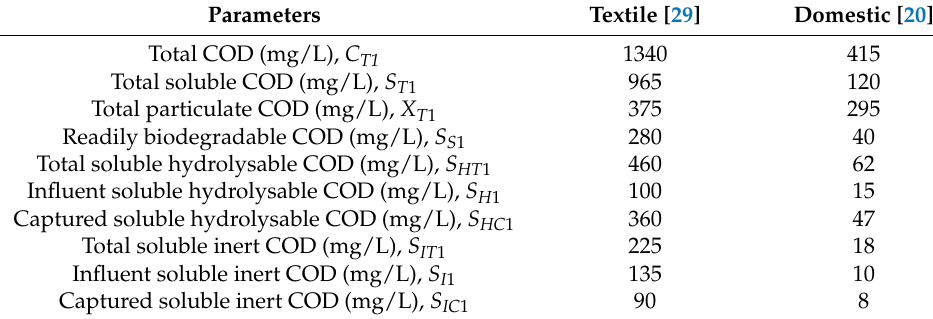
Table 2. Modified COD fractionation for textile and domestic wastewaters.